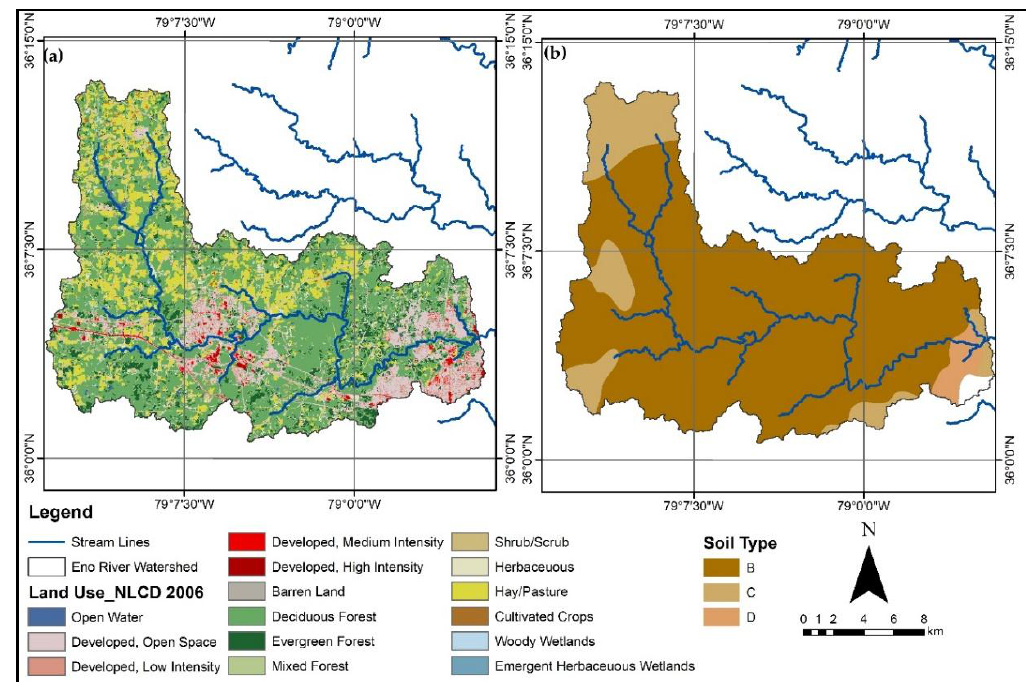
Figure 2. ( a ) National Land Cover Dataset (NLCD) 2006 land use and ( b ) State Soil Geographic (STATSGO) soil hydrologic groups within Eno River watershed study area. The grid represents 1/8° cells, showing the spatial resolution of the downscaled climate data.